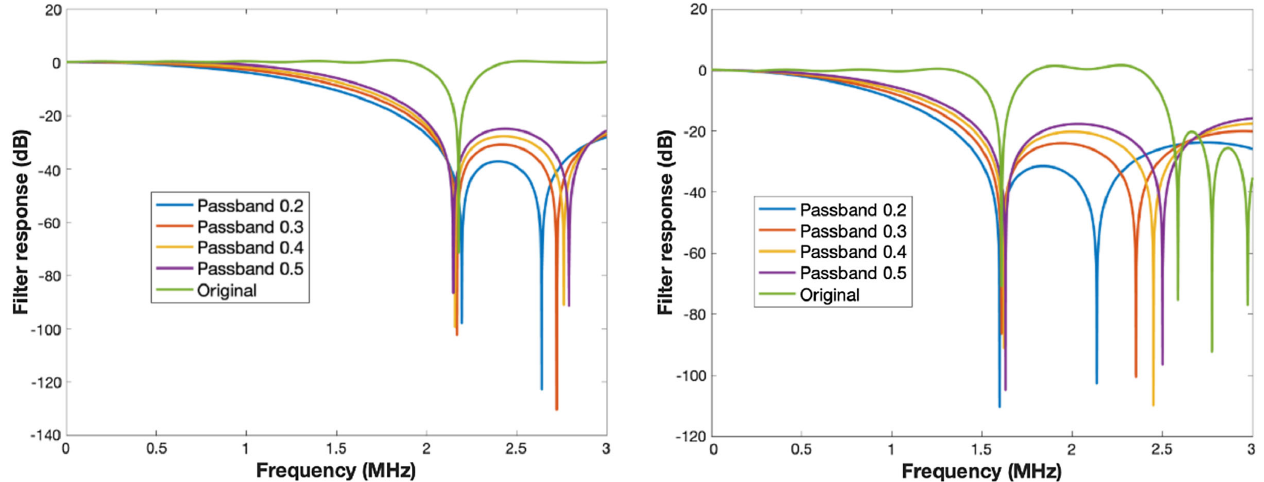
f Þ filter comparison. Left: three-section cavity. Right: four-section FIG. 19. H cav ð